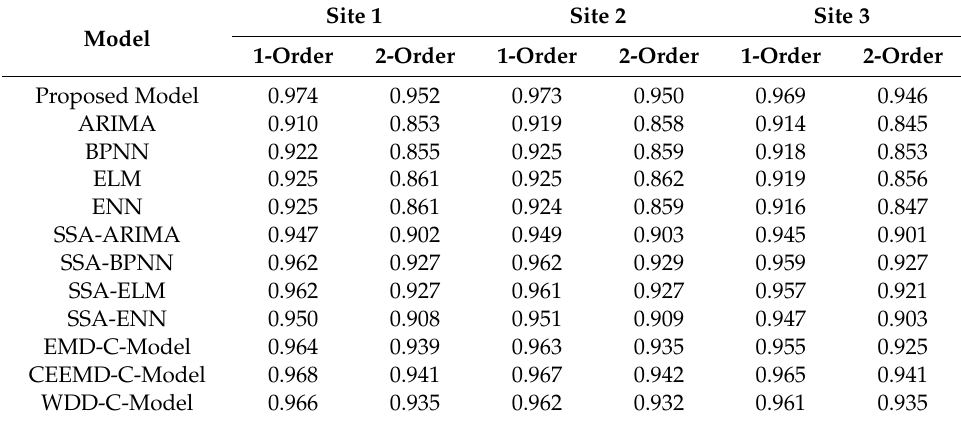
Table 9. Forecasting e ff ectiveness of our proposed combined